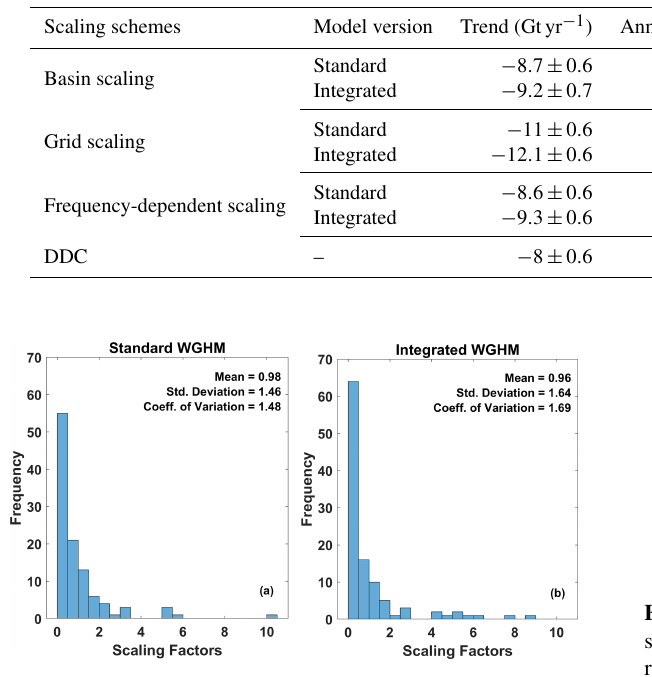
Figure 11. Frequency distributions of grid scaling factors from (a) standard and (b) integrated WGHM versions for the Indus Basin. The mean, standard deviation, and coefficient of variation (CV) are inset. Negative scaling factors are excluded.